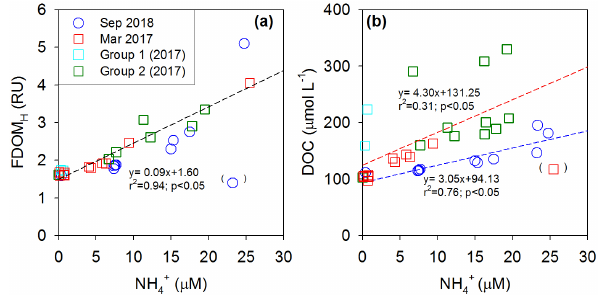
Figure 5. Plots of NH + concentrations versus (a) FDOM H concen- 4 trations and (b) DOC concentrations in Sihwa Lake in March 2017 (red square) and September 2018 (blue circle). The dashed lines represent the regression